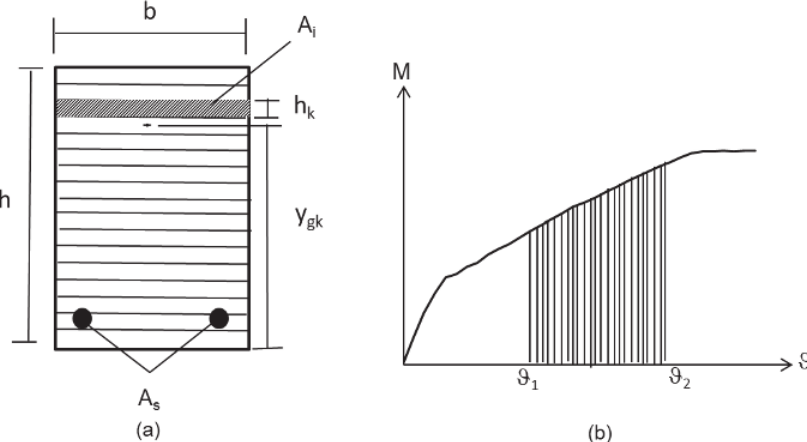
Figura 12 Análise seccional de vigas de CRF: a) seção transversal (lamelas); b) diagrama